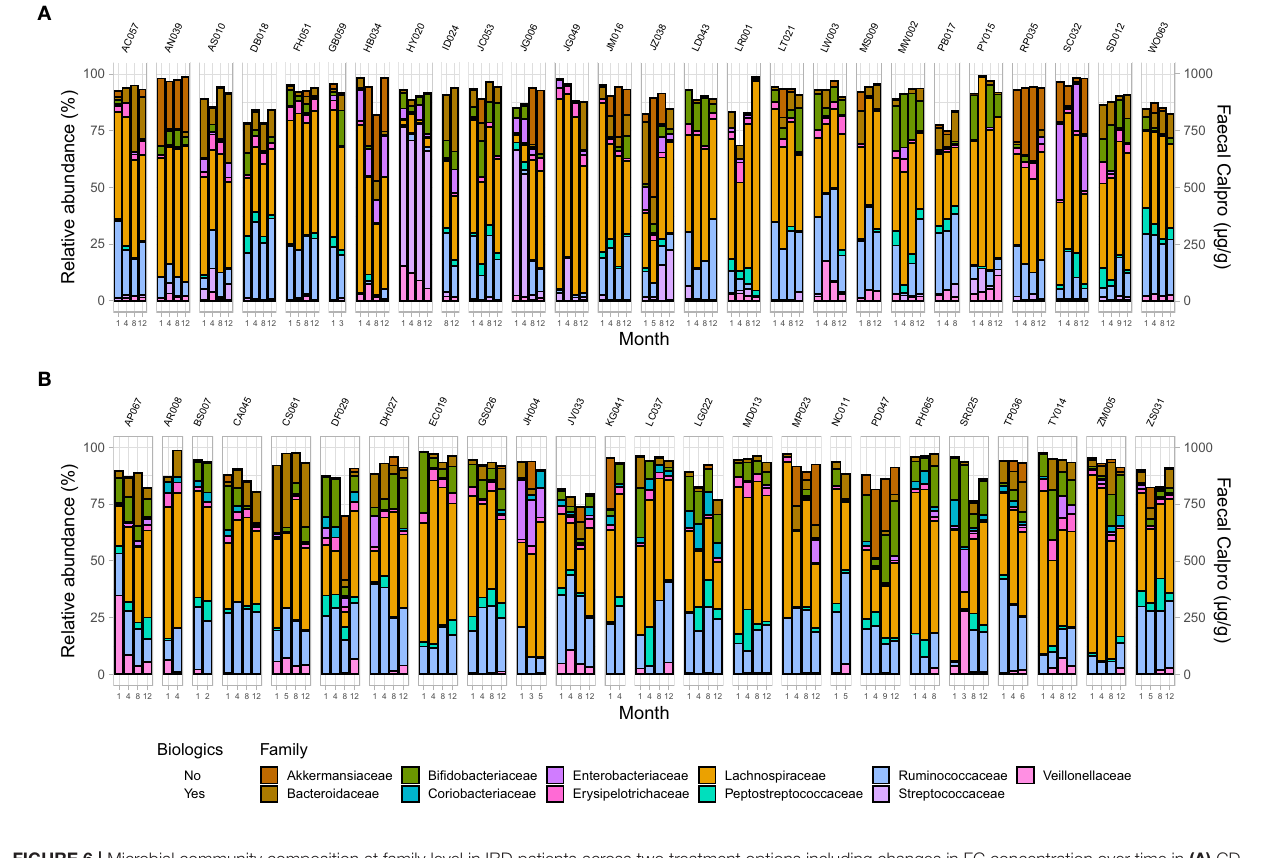
Frontiers in Medicine |